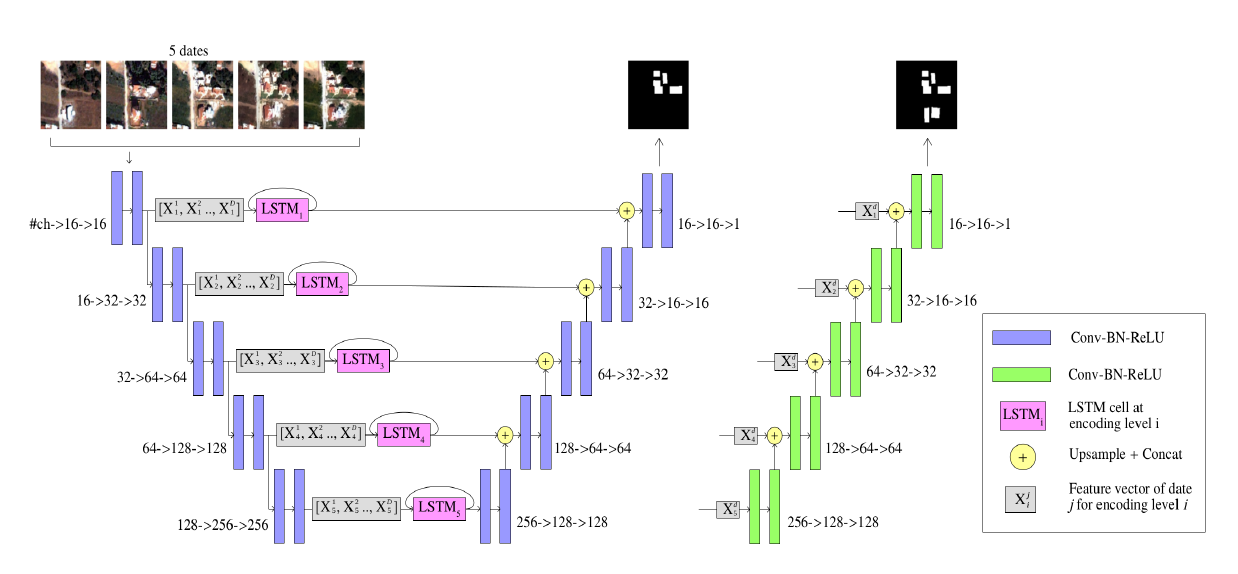
Figure 1. Graphical illustration of the proposed multi-task deep architecture. The fully convolutional LSTM network depicted on the left is further enriched with the additional building segmentation decoding branch depicted on the right. Every encoding level i results in five spatial feature vectors which are fed to the LSTM cell so that the hidden state can be calculated and concatenated with the corresponding decoding level. Spatial feature vectors of certain dates d , in our case d ∈ { 1 , D } , are also concatenated with the corresponding feature vectors of the building segmentation decoding